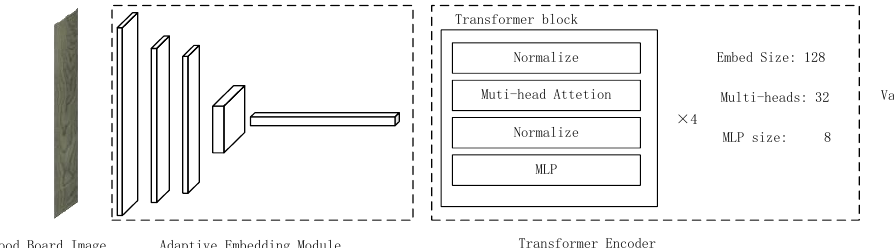
Figure 9. Improved Vision Transformer network structure.